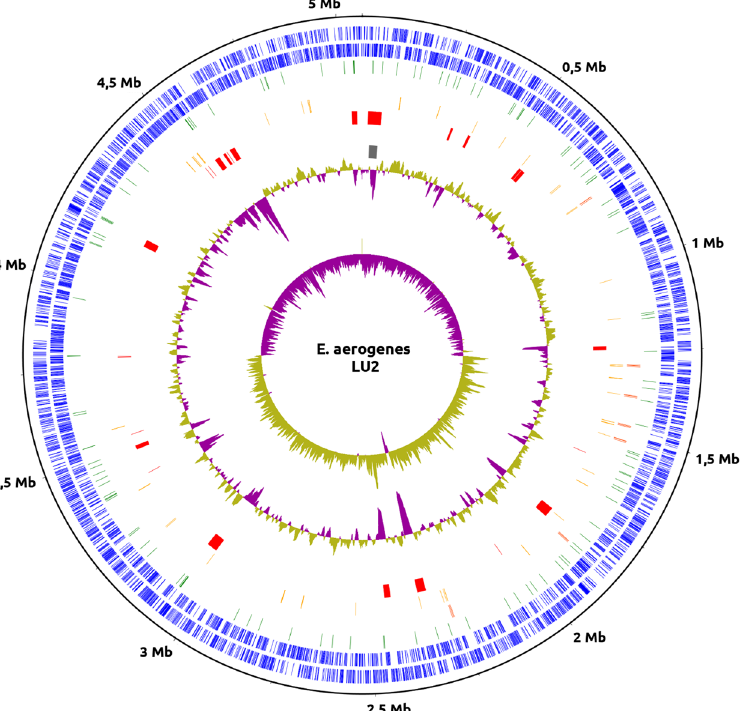
Figure 1. Circular map of Enterobacter aerogenes LU2 genome. From outer circle to inner circle, representation is as follows: 1. Position in megabases (black); 2. Forward strand CDSs (blue); 3. Reverse strand CDSs (blue); 4. Pseudogenes (green); 5. rRNAs (dark orange); 6. tRNAs (orange); 7. Horizontal gene transfer (HGT) regions (red); 8. Phage sequences (grey); 9. GC content (mustard and purple color correspond to higher and lower than average GC content, respectively); 10. GC skew (mustard and purple color correspond to higher and lower than average GC skew, respectively). The whole-genome sequence visualization was performed using CGView software,